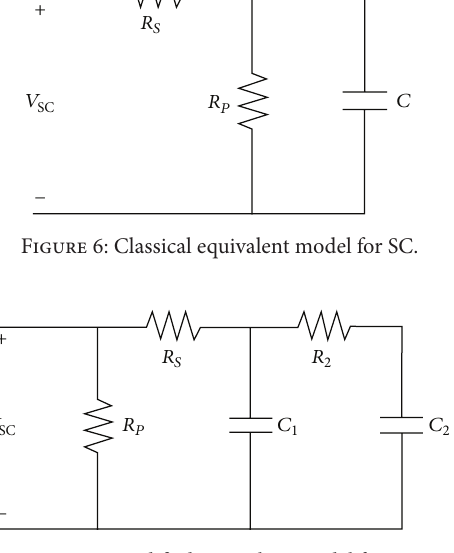
Figure 7: Modified equivalent model for SC. Table 1: Lithium ion battery bank